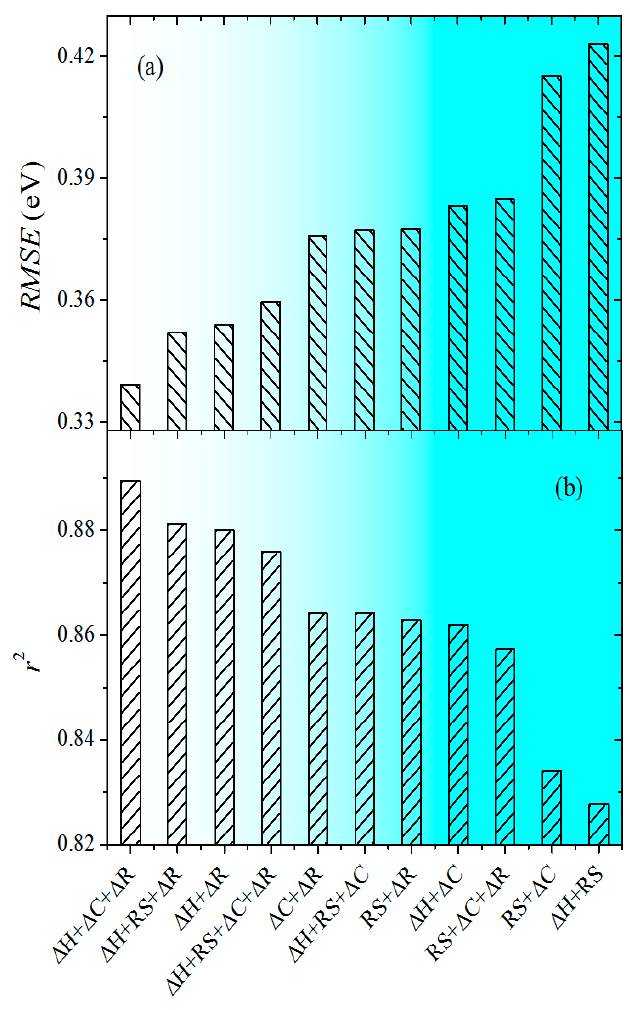
Figure 4. Comparison of values of (a) root mean square error (RMSE) and (b) r 2 of the SVM models with RBF kernel for different input features.